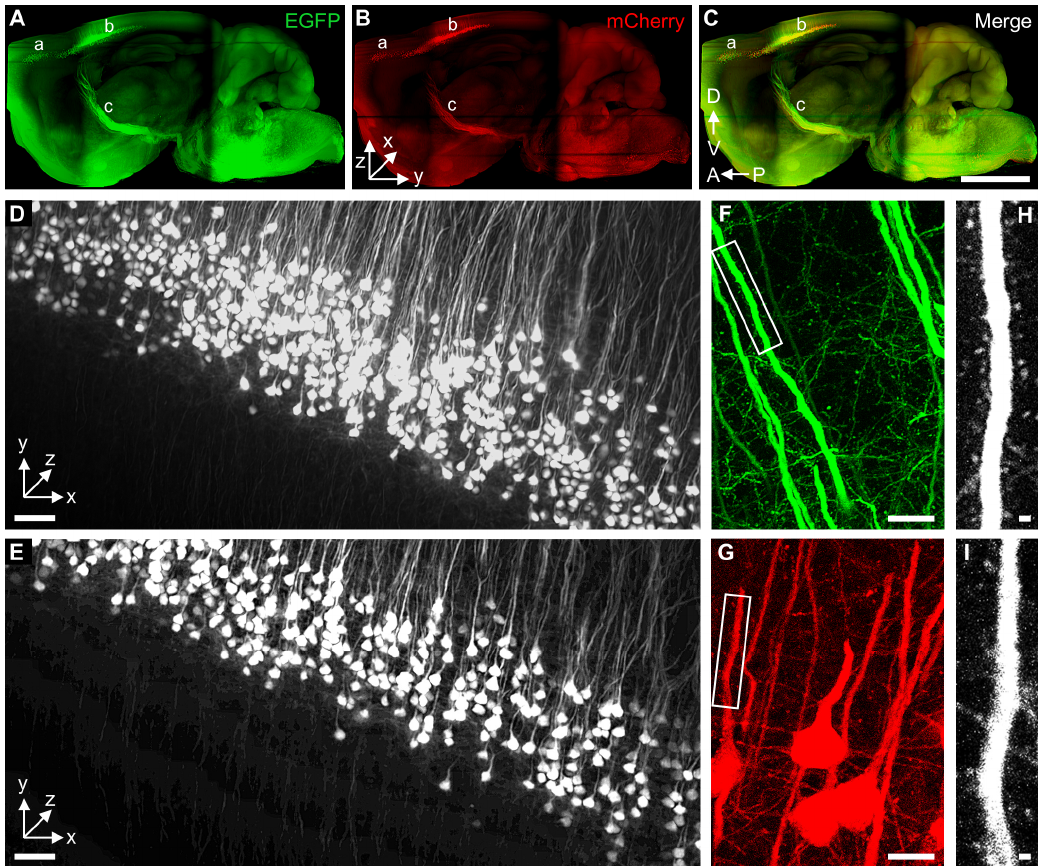
Figure 4. Three-dimensional visualization of AAV-labeled supraspinal neurons projecting to the cervical spinal cord. ( A – C ) Lateral view of the 3D reconstruction of supraspinal neurons and tracts labeled by AAV2-Retro. A-P: anterior to posterior; D-V: dorsal to ventral. The images were acquired with a Z.1 light-sheet microscopy (Zeiss, Germany) equipped with a 5×/0.16 Plan Neofluar objective at a zoom of 0.4. ( D , E ) The magnification images of EGFP + ( D ) or mCherry + ( E ) corticospinal neurons (CSNs) in the cortex. The images were acquired with a Z.1 light-sheet microscopy equipped with a 5x/0.16 Plan Neofluar objective at a zoom of 2.5. ( F – I ) High-resolution confocal imaging of 2 mm thick cleared brain slices using an LSM700 equipped with a C-Apochromat 40×/1.20 water objective at a zoom of 2.0. Representative images of EGFP + ( F , H ) and mCherry + ( G , I ) are shown. a, forelimb area; b, the central population in the sensorimotor cortex; c, the corticospinal tract. D-V: dorsal to ventral; A-P: anterior to posterior. Scale bars: ( A – C ), 2 mm; ( D , E ), 50 μ m; ( F , G ), 10 μ m; ( H , I ), 1 μ m.